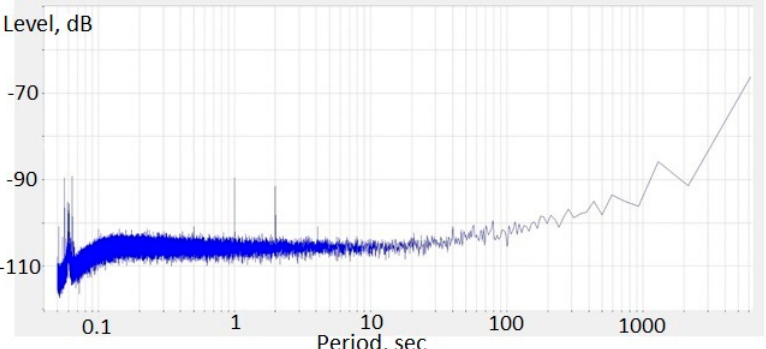
Figure 10. Power spectral density of molecular electronic angular accelerometer with negative MHD feedback in units of input angular acceleration in decibels relating to 1 rad/s 2 √ Hz.